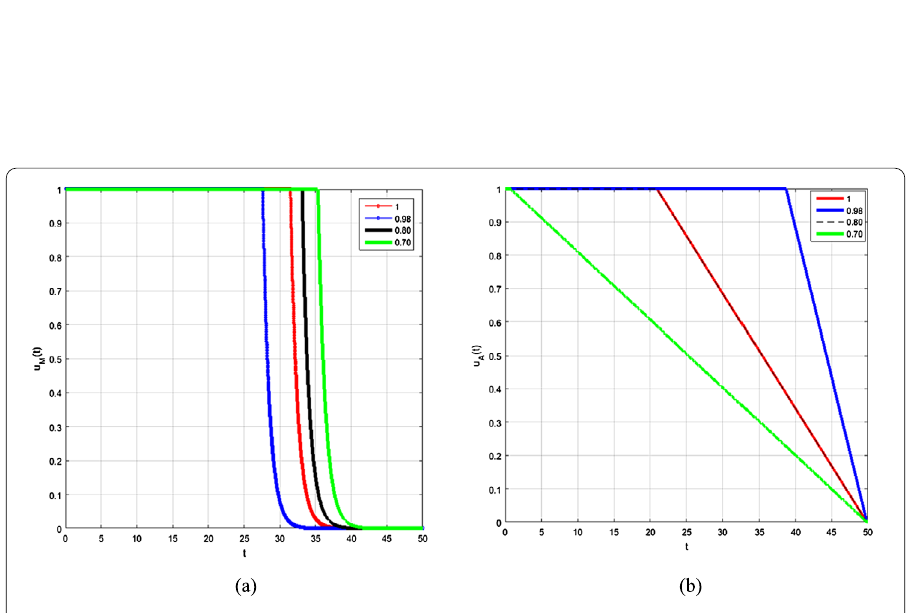
Figure 4 The control variable simulations by N2LIM at different